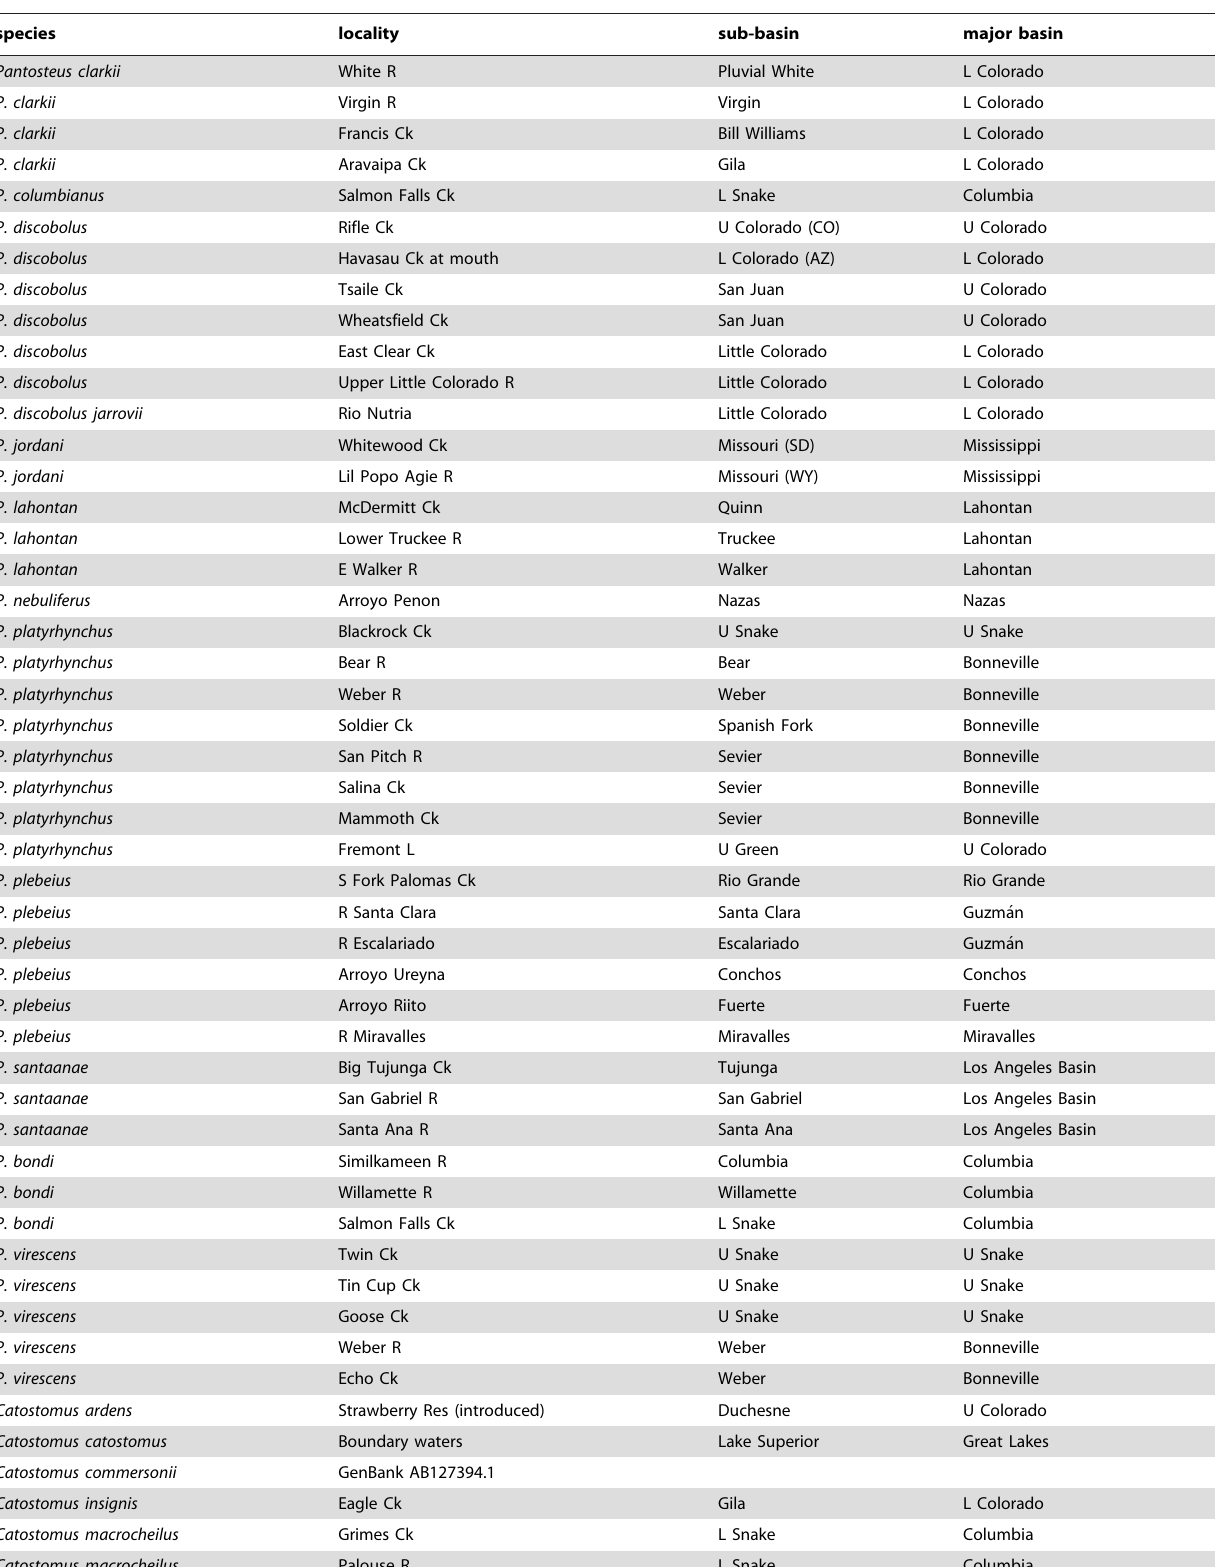
Table 1. Locality data for all Pantosteus samples and outgroups.